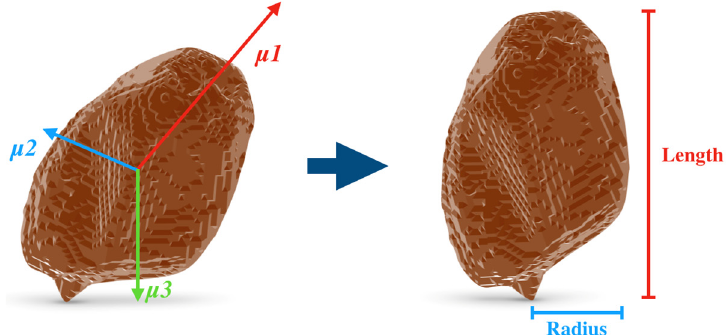
Figure 13. Computation of length and radius of grains by PCA.